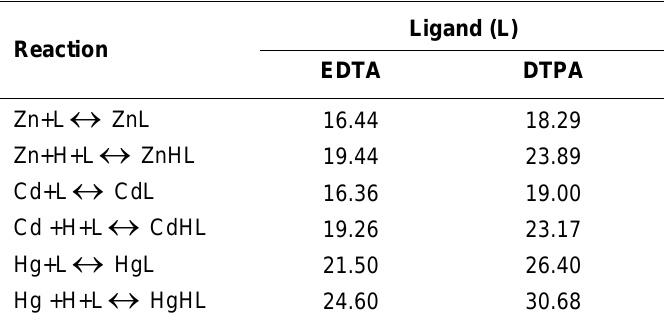
Stability Constants